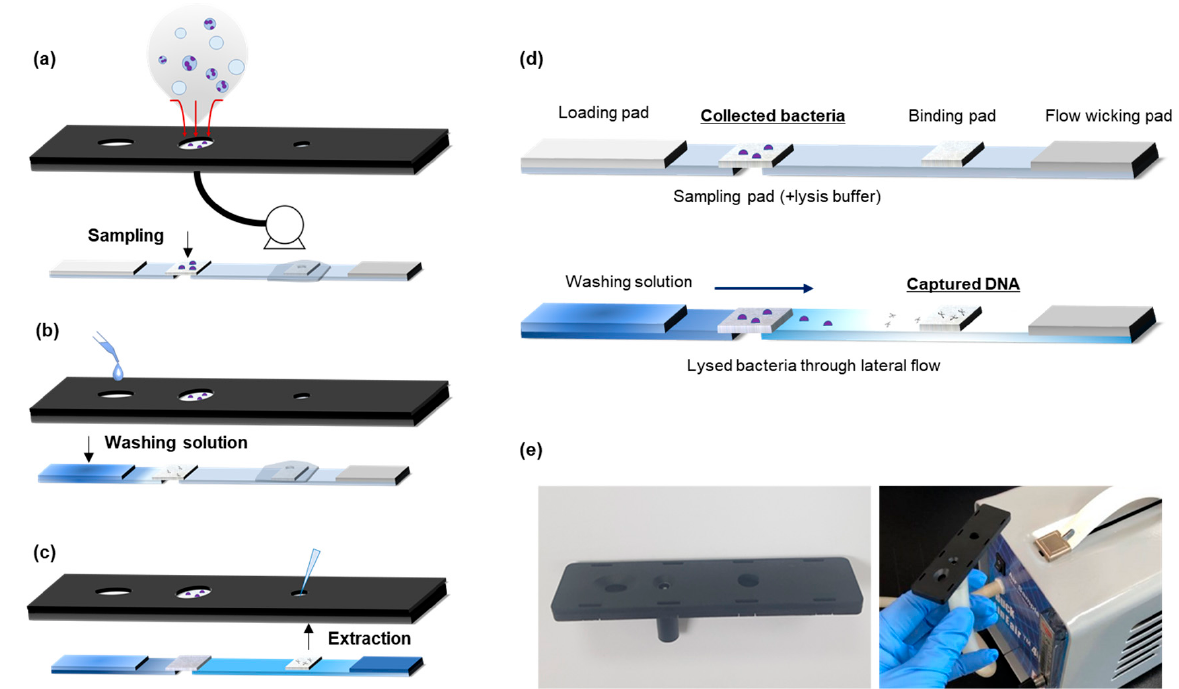
Figure 1. Workflow of the paper kit: ( a ) aerosol sample collection using air pump, ( b ) loading of washing solution at hole in the case, ( c ) DNA extraction through lateral flow in the strip, ( d ) schematic of aerosol collection and DNA extraction process, and ( e ) photographs of the paper kit with 3D ‐ printed case and air pump.